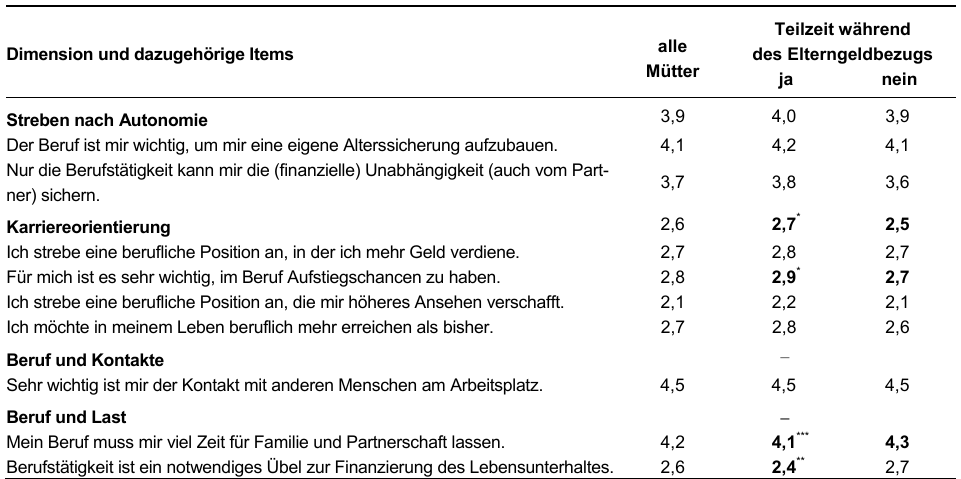
Tabelle 2 : Bewertung individueller Motive der Erwerbstätigkeit, nach Teilzeitnutzung (durchschnittlicher Zustimmungswert auf der Skala von 1 bis